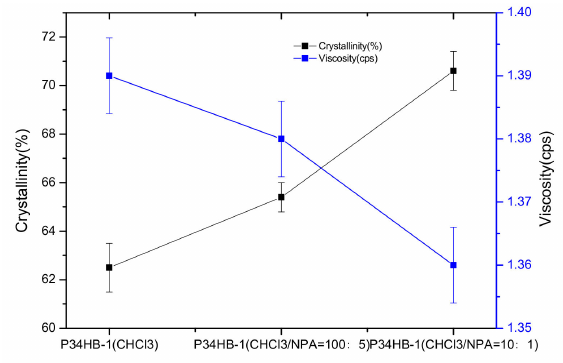
Figure 8. Crystallinity and viscosity of P34HB-1.